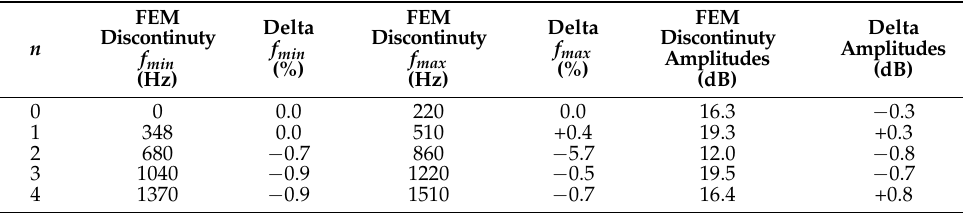
Table 6. Comparison between experimental and FEM with discontinuity data of simple expans- ion chamber.